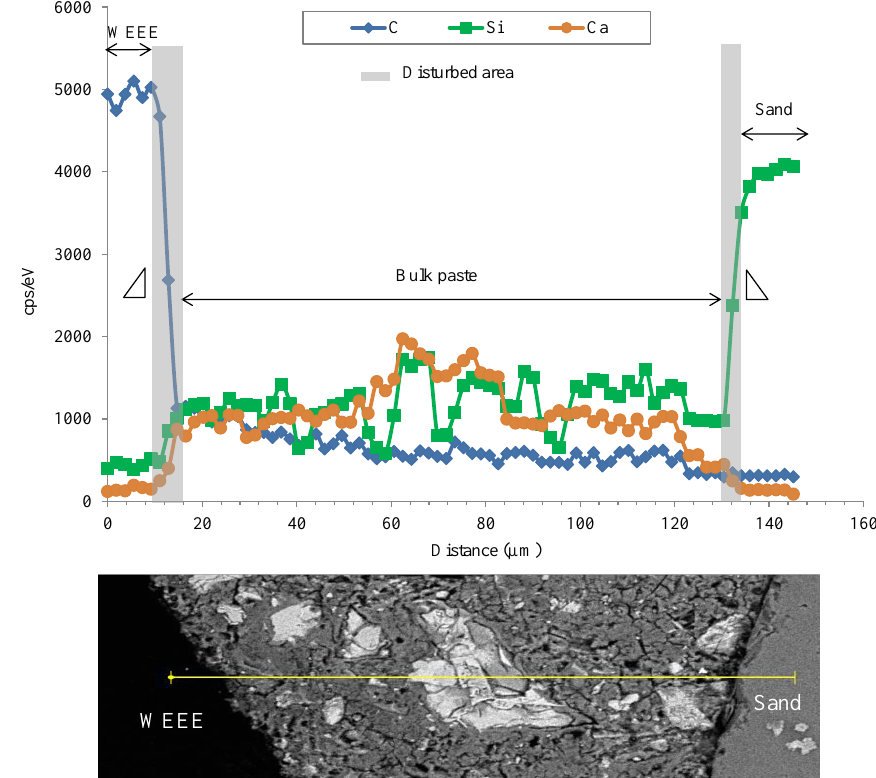
Figure 7. An example of Energy-Dispersive X-Ray analysis (EDX) of WEEE/cement matrix and sand/cement matrix interface.